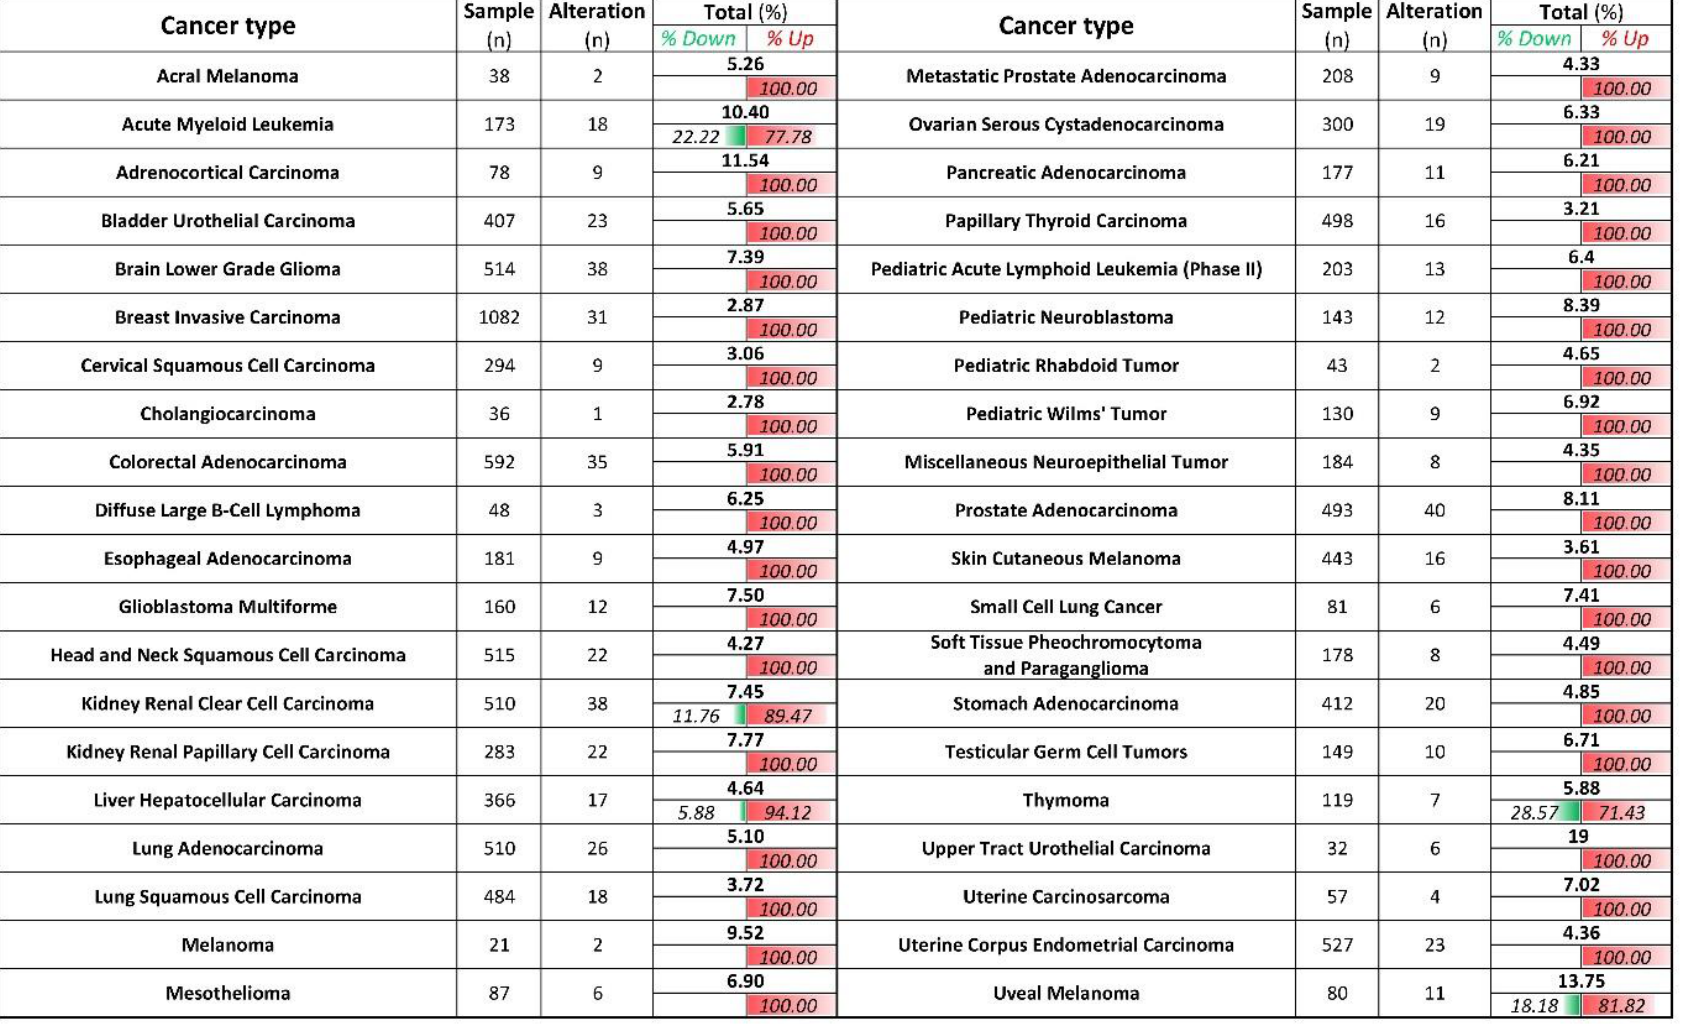
Figure 6. ZIP8 is up-regulated in cancer tissues and cell lines. ZIP8 mRNA expressions in 40 types of cancer were obtained from TCGA database. z-score threshold was set at ± 2.0. The number of % alteration in each of the analyzed datasets was listed and further divided into the ratio of down-regulated and or up-regulated expression.